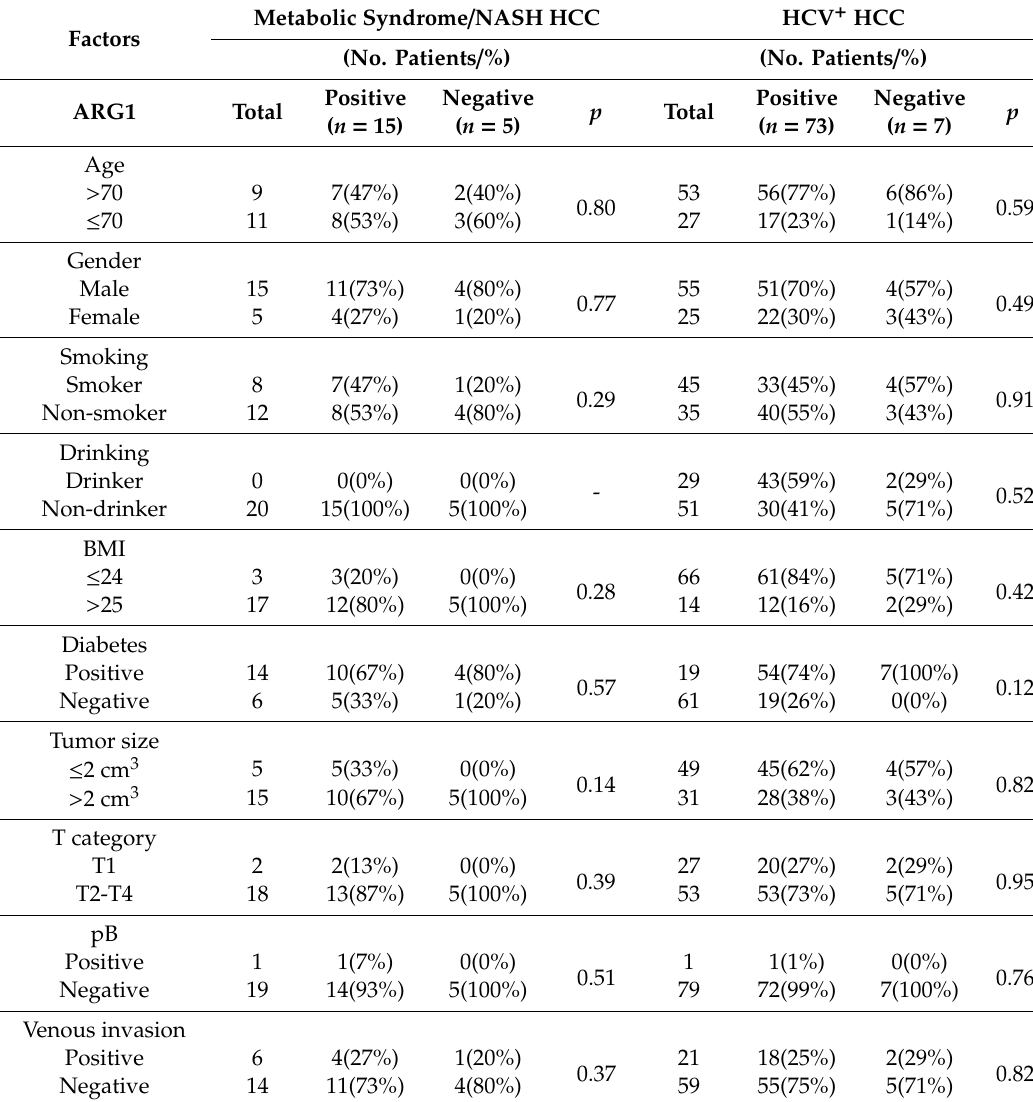
Table 2. Correlation between ARG1 expression and clinicopathological